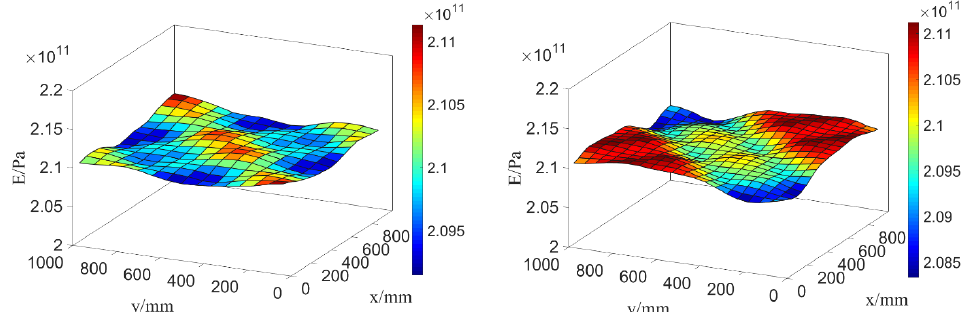
× elements ( left ) and